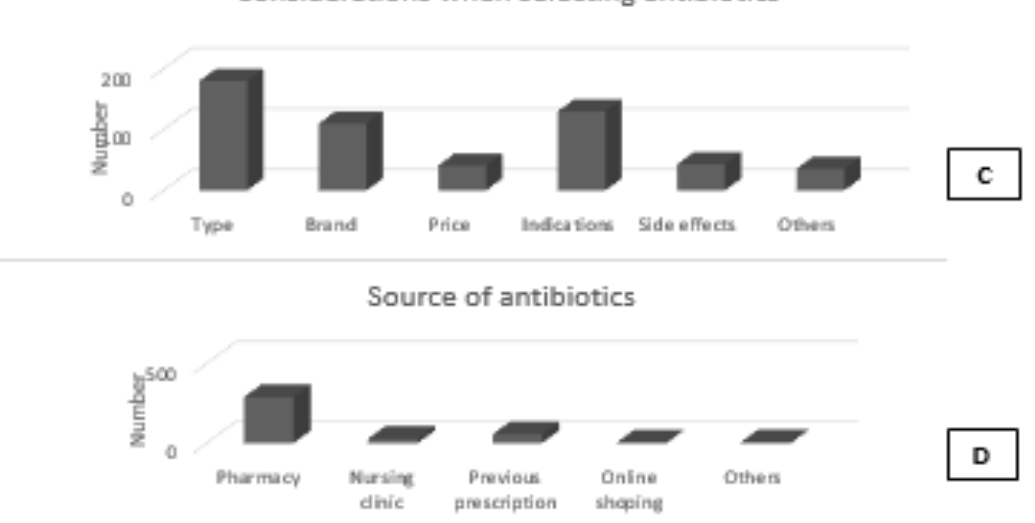
Figure 3. A. Complaint for self-medication with